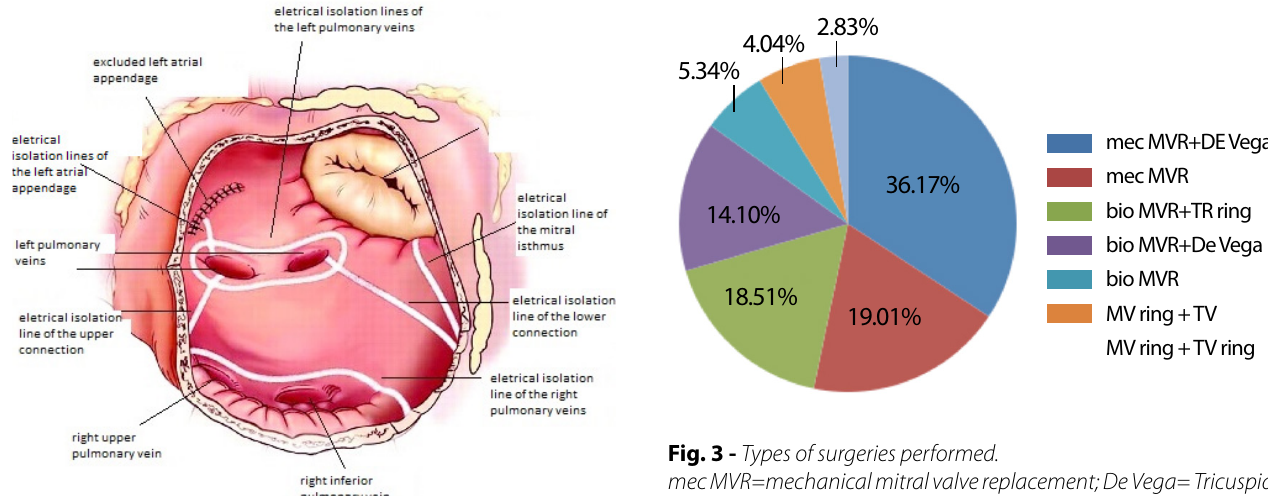
Fig. 2 - Lines of tissue lesion by radiofrequency in the left atrium. Adapted from Weimar et al. [23] .